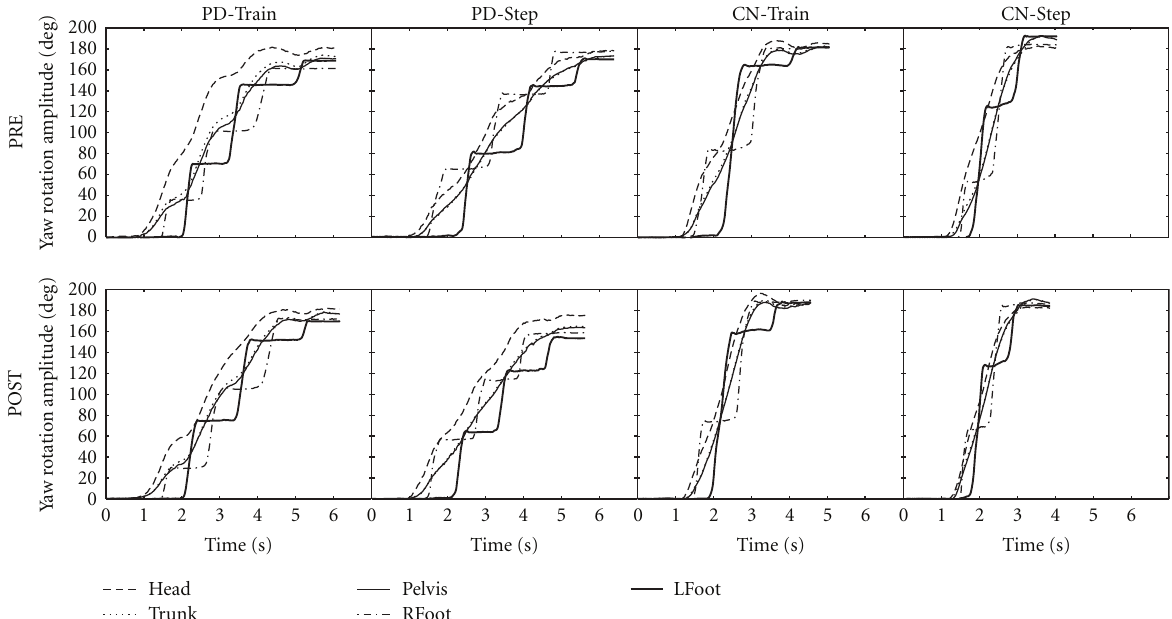
Figure 3: Turn Kinematics Examples. Representative traces of yaw plane rotations of individual body segments during a single 180 ◦ in-place turn in one PD-Train, one PD-Step, one CN-Train, and one CN-Step participant before (PRE) and after (POST) intervention.